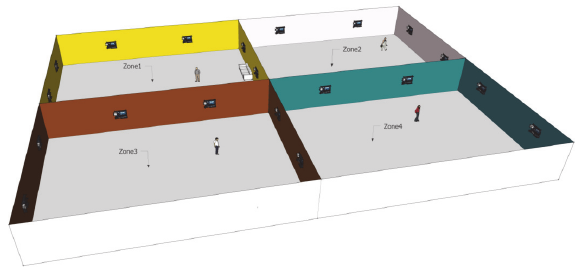
Figure 11: Figure of the room